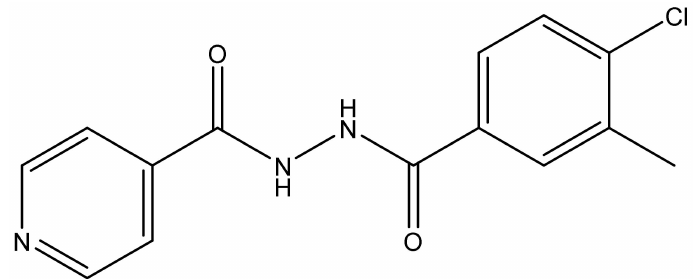
Figure 6. Chemical structure of